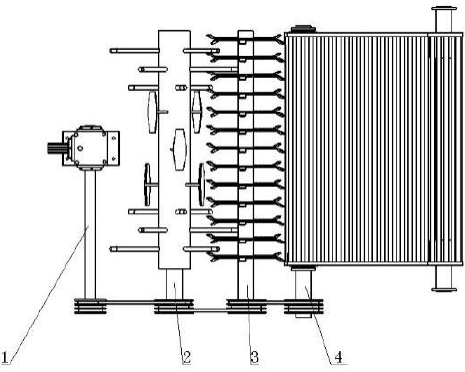
Figure 2. Power transmission route: 1. transmission output shaft; 2. Vine picking roller; 3. vine killing roller; 4. elevator drive shaft.